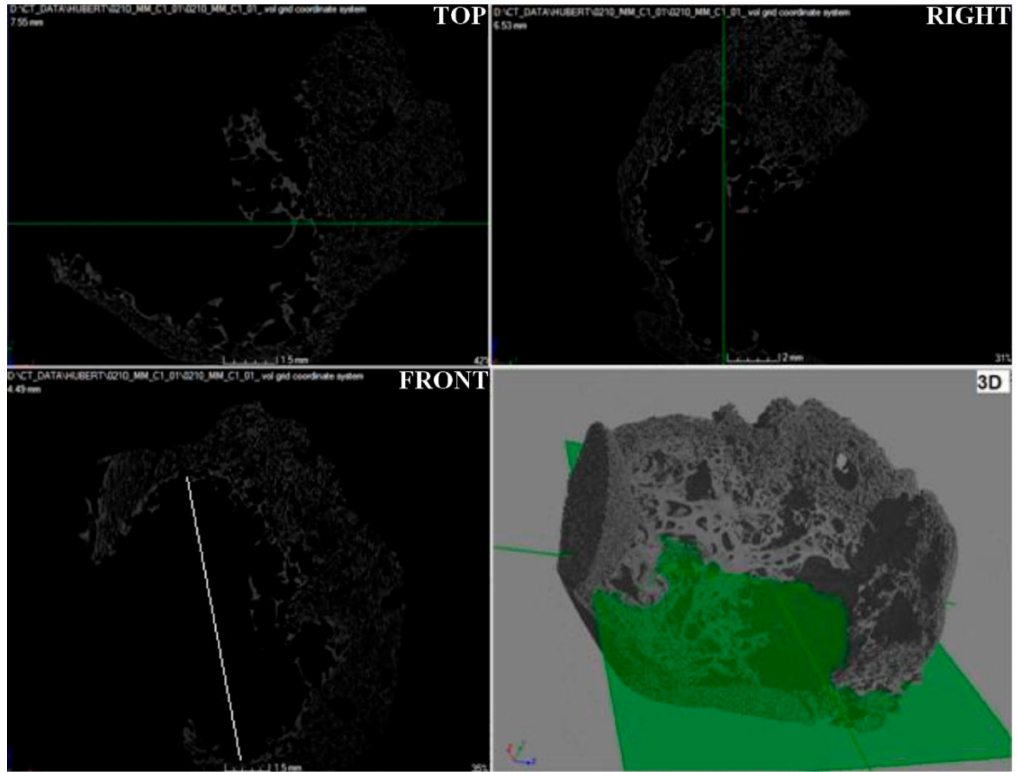
Figure 16. Microtomographic image of carbon sample